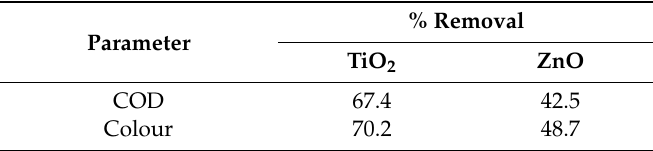
Table 2. Comparison of TiO 2 and ZnO on photocatalytic degradation (process conditions: pH—4, UV light irradiation—64 W, catalyst dosage—500 mg /